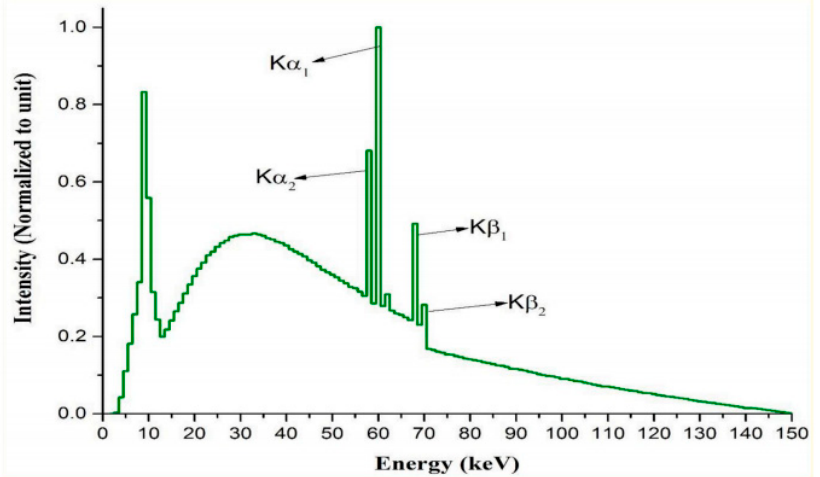
Figure 2. The conducted X-ray spectrum by Monte Carlo simulations via the TASMIC package for 150 kV tube voltage.